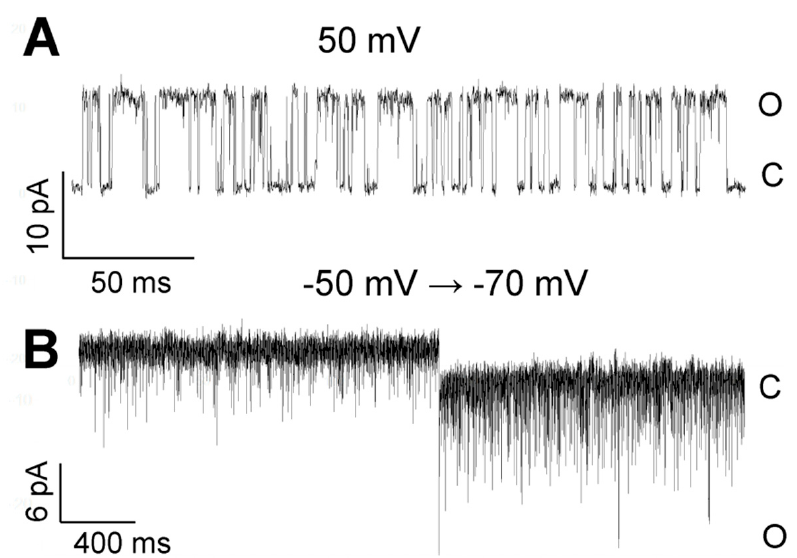
Figure 10. Examples of TREK-2-like channel activity in two different modes in the cell-attached configuration. ( A ) Burst of a well-resolved openings at 50 mV; a low-pass filter of 5 kHz. ( B ) The flickering mode: the potential changed from − 50 mV to − 70 mV; a low-pass filter of 5 kHz. The bath solution contained 1.7 mM Ca2+.